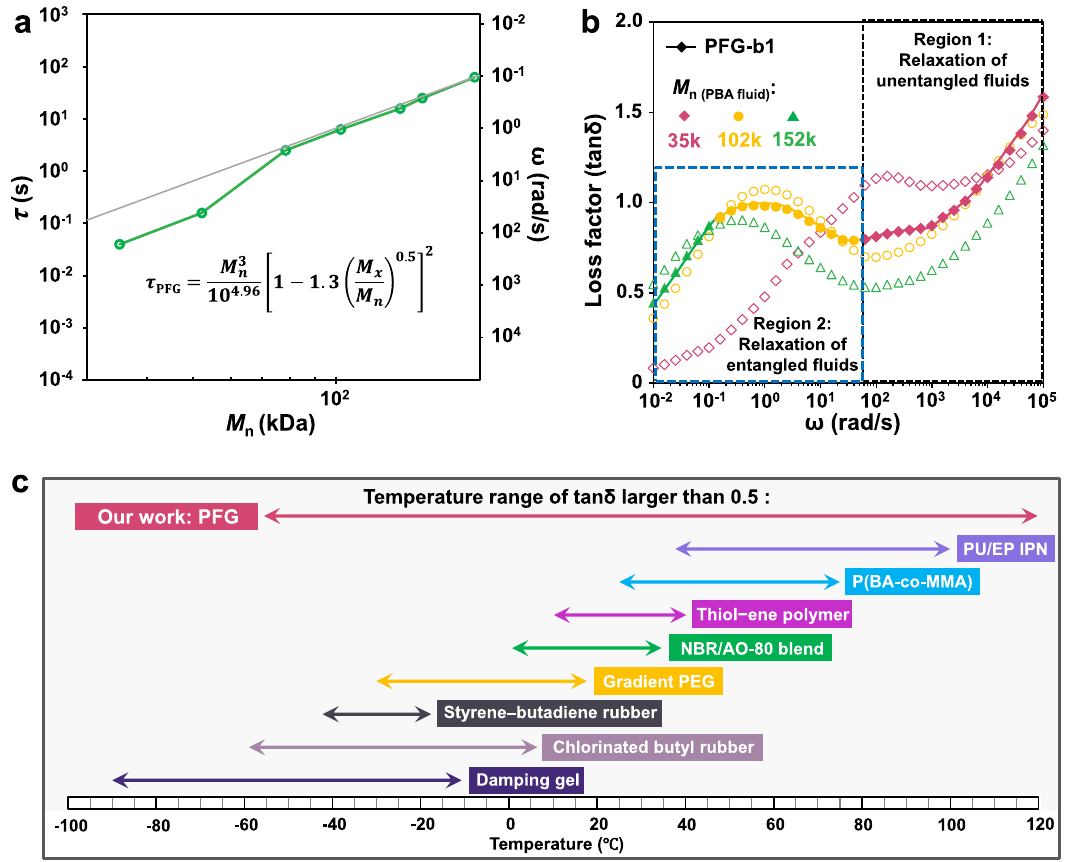
Fig. 4 Precise macromolecular design of high damping polymer- fl uid-gels (PFGs) over a broad frequency range. a The reptation model predicts the whole chain reptation time ( τ ) of poly (n-butyl acrylate) (PBA) fl uids in a fi xed network. b Frequency dependence of loss factor (tan δ ) at 25 °C for PFG-b1 containing three different molecular weights ( M n (PBA fl uid) ) PBA polymer fl uids of a weight fraction of Φ PBA fl uid = 60%. In the high-elastic region of the bulk network, multiple distinct peaks of tan δ can be observed, which demonstrates that the whole chain motion of polymer fl uids takes place stepwise. c The temperature range of tan δ larger than 0.5 of the PFGs compared to the reported damping materials (see Supplementary Table 4 for